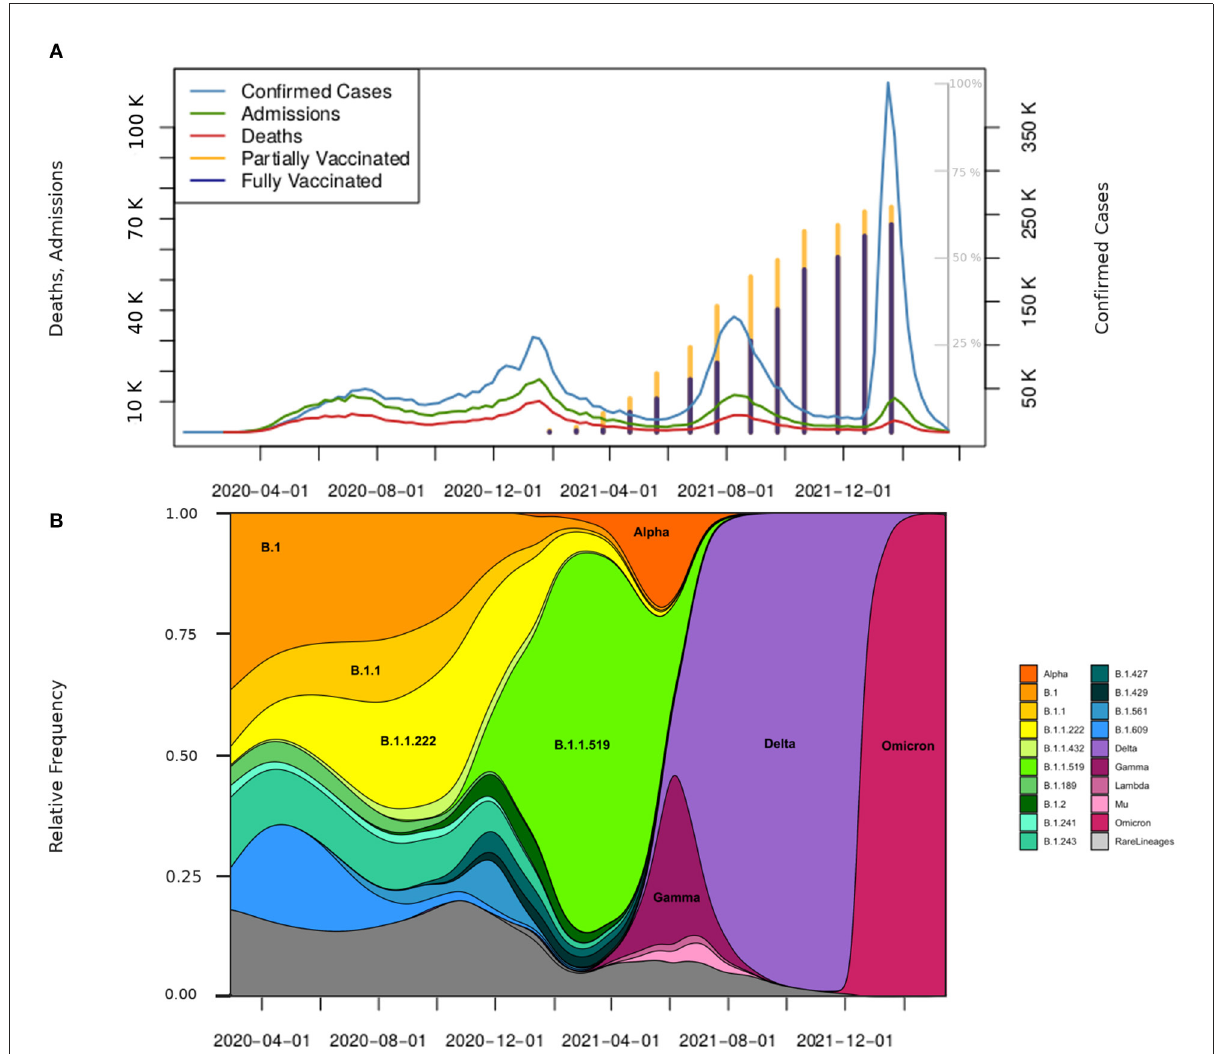
FIGURE2 Confirmed cases, hospitalizations, deaths, vaccinations, and the presence of variants in Mexico. (A) Weekly distribution of CCs (scale on the right), hospitalizations, and deaths (scale on the left). The stacked bar plot in this figure presents the share of people partly (yellow bar) and fully vaccinated (navy bar). The percentage scale is displayed in gray on the inner right area of the plot. Bars are placed at the midpoint of the respective month beginning in January 2021. (B) Distribution of variants in the study period. The main variants that circulated in Mexico in the four evaluated periods are